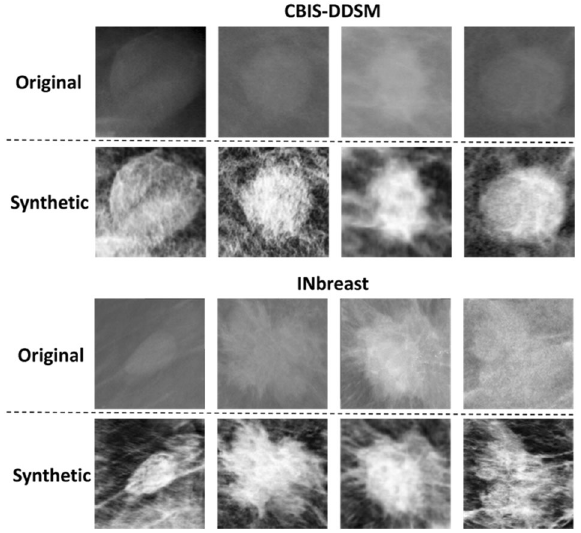
Fig. 2 Samples of synthetic data from CBIS-DDSM and INbreast datasets generated by CycleGAN model using the private dataset. Top rows in each subplot show original mammograms respectively from CBIS-DDSM (INbreast) dataset. Bottom rows show their corresponding synthetic mammograms generated by CycleGAN model that was trained respectively between CBISDDSM (INbreast) and the private dataset.